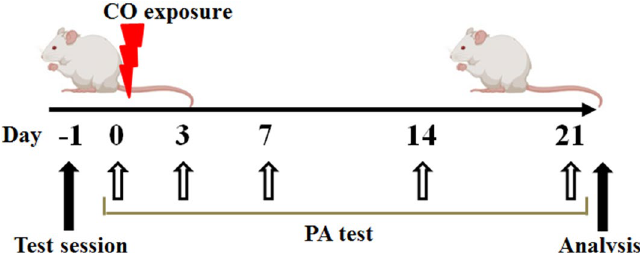
Figure 6. Time line of this study. The rats are received in the training session as the passive-avoidance (PA) test (Day -1) and are measured without foot-shocks 24 h later (Day 0). Then, rats are exposed to CO, and the latencies are measured at days 3, 7, 14, and 21 after exposure. The analyses of immunohistochemistry, flow cytometry, and quantitative reverse transcription-PCR are performed on day 21 after CO poisoning. This figure was created with